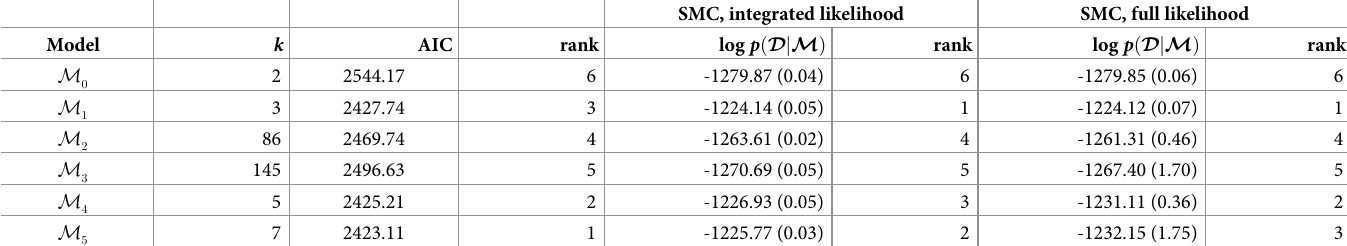
Table 3. Comparison of models for the Minnesota radon contamination dataset, using AIC and model evidence. The model evidence was computed with sequential Monte Carlo (SMC), using separately the integrated likelihood presented and the full likelihood. This was repeated for 8 random initialisations with 2000 draws at each step in SMC, and we present the mean and standard deviation of the model evidence from each run. The table also shows the number of model parameters, k , and the rank- ing (where smaller is better) of models for each